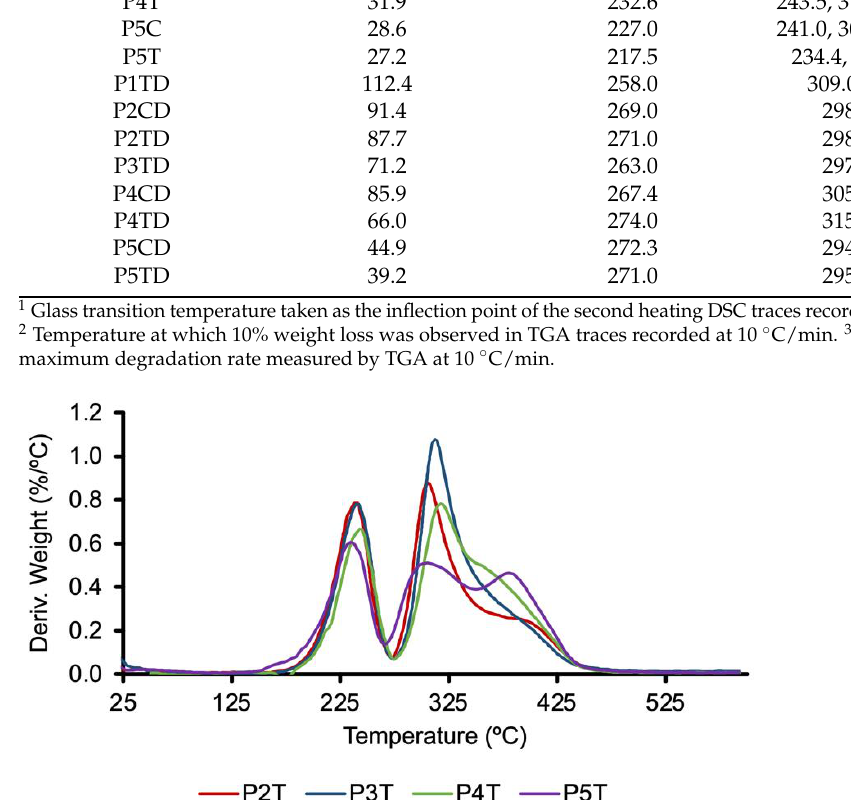
Table 2. Thermal analysis data of N -Boc-protected and deprotected polytriazoles.